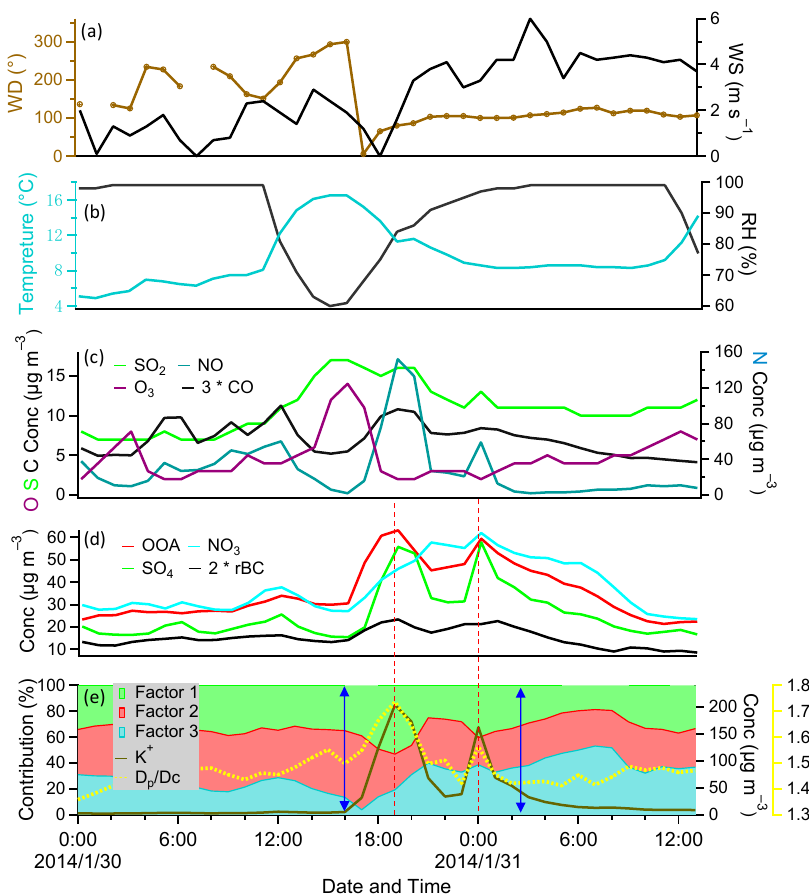
Figure 6. Time series of hourly average ( a ) wind speed, wind direction, ( b ) temperature, relative humidity, ( c ) mass concentrations of sulfur dioxide, nitric oxide, ozone, carbon oxide, ( d ) mass concentrations of oxygenated organic aerosol, nitrate, sulfate, rBC, ( e ) D p / D c , contribution of di ff erent components and potassium ion mass concentrations. Note that concentrations of CO (3*CO) and rBC (2*rBC) have been multiplied by the factors of 3 and 2, respectively, to better visualize their trends.